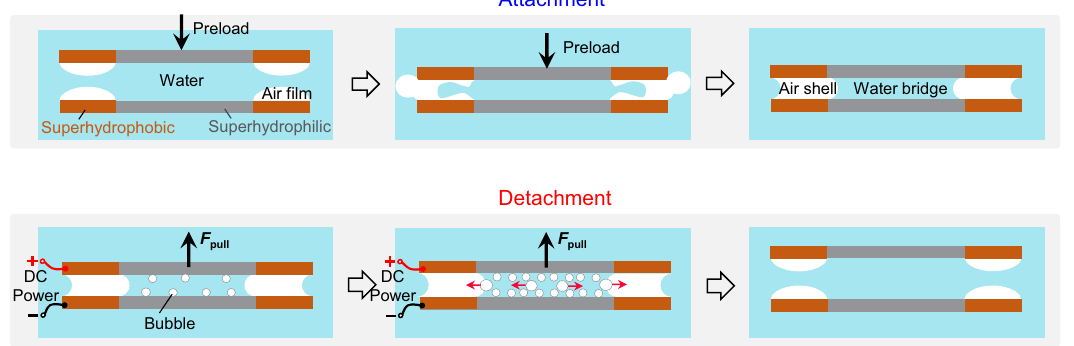
Fig. 1 | Schematic illustration of the working mechanism for the electrically triggered reversible underwater adhesion. During the attachment process, the formation of spatially con fi ned outer air shell can not only protect the inner water bridge from the water environment, but also enhances the overall underwater